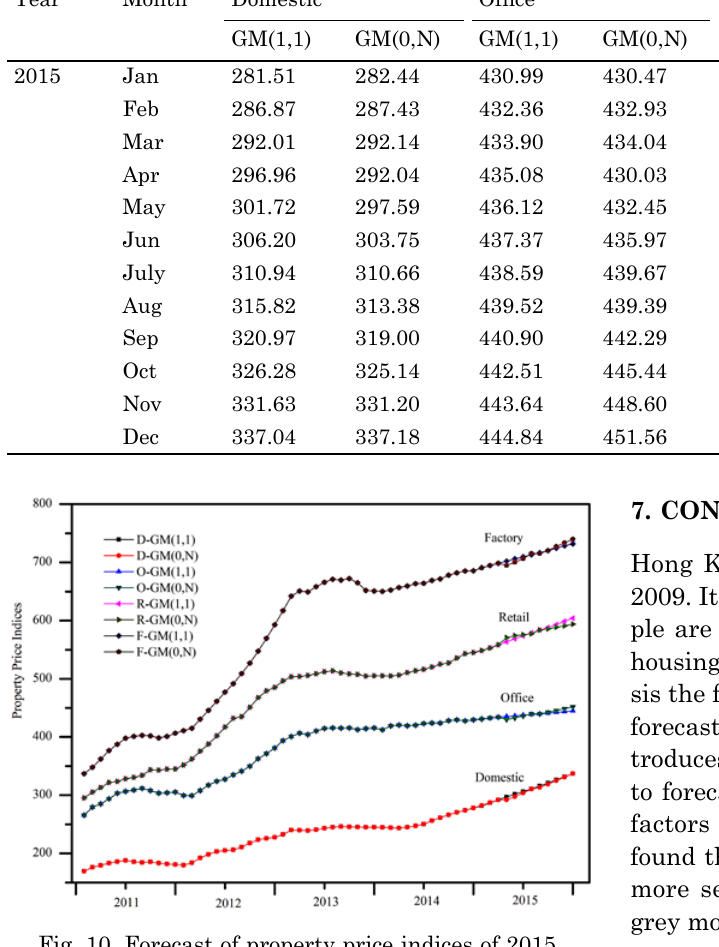
Fig. 10. Forecast of property price indices of